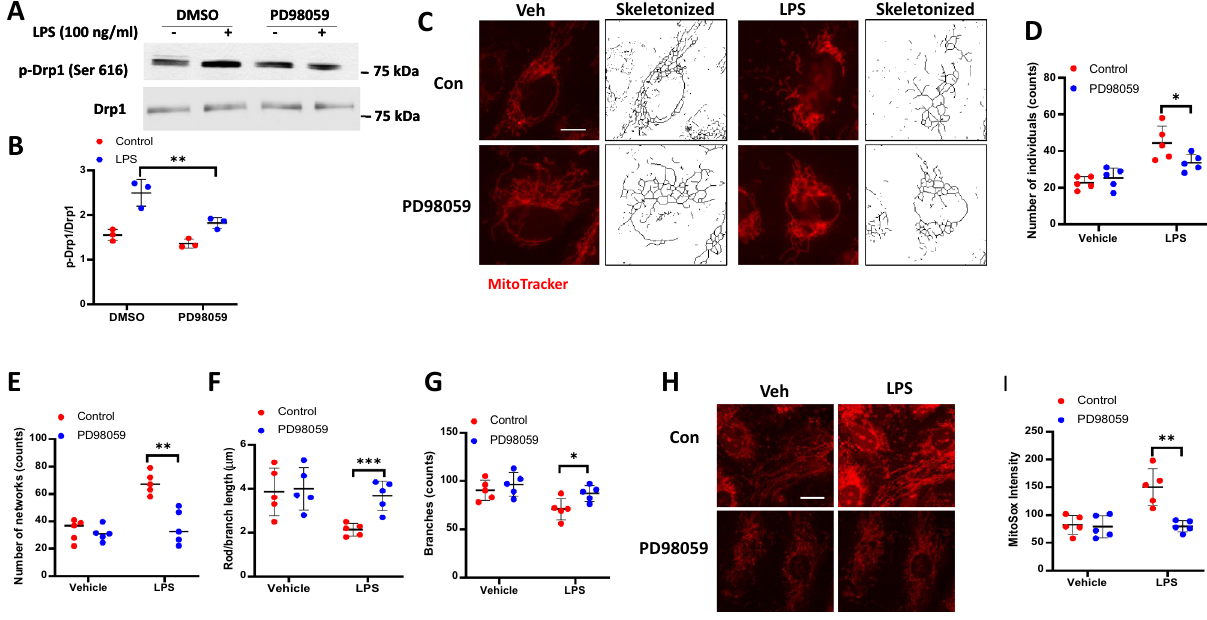
Figure 6. Erk mediates DRP1 phosphorylation and LPS-induced mitochondrial fission. ( A ) HLMVECs were pretreated with PD98059 for 30 min followed by LPS for 30 min, phosphorylation of DRP1 was analyzed by Western blot. ( B ) Results of quantitative analysis are shown as intensity ratio of phosphorylated DRP1 to total DRP1. Values are means ± SD of 3 independent experiments. **p < 0.01, LPS versus LPS + PD98059. ( C ) HLMVECs were pretreated with PD98059 for 30 min followed by adding of MitoTracker 10 min before imaging. ( D – G ) Mitochondrial dynamics was assessed by number of individual fragments, number of networks, rod/branch length, and branch counts. Data were presented as means ± SD, for number of individual fragments, *p < 0.05, LPS alone versus LPS + PD98059; for number of networks, **p < 0.01, LPS alone versus LPS + PD98059; for rod/branch length, ***p < 0.005, LPS alone versus LPS + PD98059; for branch counts, *p < 0.05, LPS along versus LPS + PD98059. Presents are representative of at least 5 images. Scale bar 5 μm. ( H ) HLMVECs were treated same as described above and staining with MitoSOX for 10 min before imaging. Shown are representative of at least 5 images. Scale bar 10 μm. ( I ) MitoSOX intensity analysis, *p < 0.05, LPS alone versus LPS +